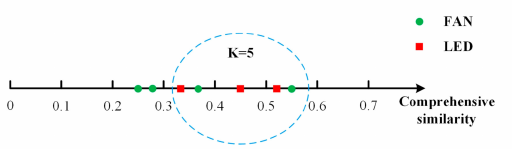
Figure 7. An example for load identification by weighted KNN.